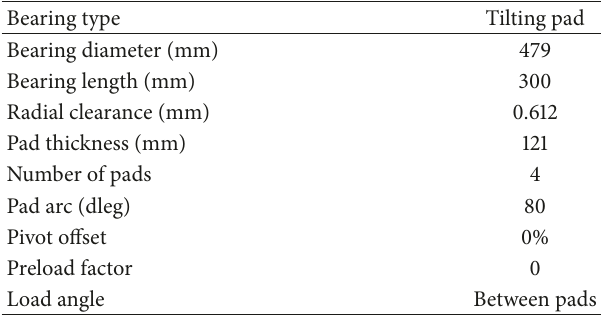
Table 1: Specifications of tested bearing [25].